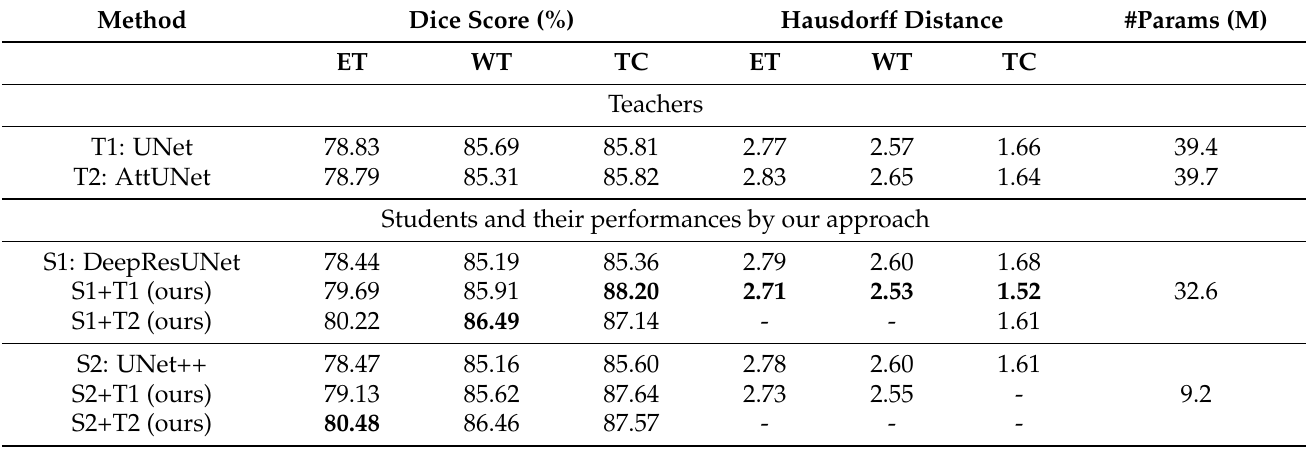
Table 1. The results of our experiments on different combinations of networks on BraTS2018. The bold values are the highest Dice scores and lowest Hausdorff distances in their columns. When the segmentation index of the teacher was lower than that of the student, theoretically, knowledge distillation was not applicable to this situation.